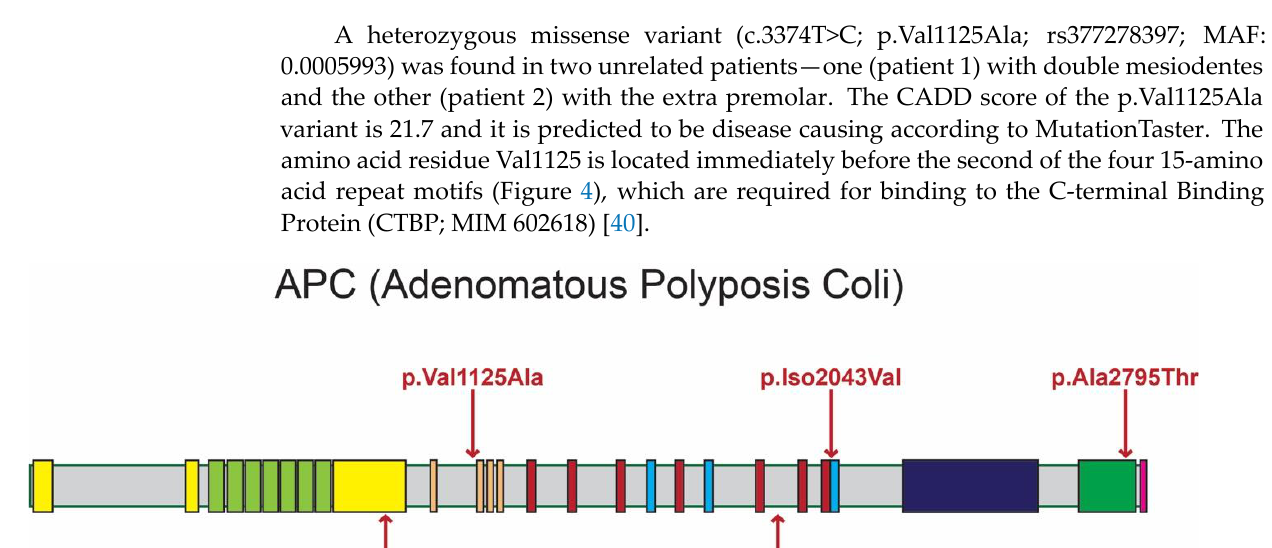
Figure 5. The Ile2043Val missense variant in the SAMP3 domain of APC may impact the strength of interaction with AXIN. Human APC SAMP3 domain is shown in beige while the RGS domain of AXIN is coloured mauve. Isoleucine 2043 in wildtype human APC has four contacts with the AXIN RGS domain: three with Asp116 and one with Phe119. The valine substitution in APC is predicted to reduce the contacts with Asp116 to just one.